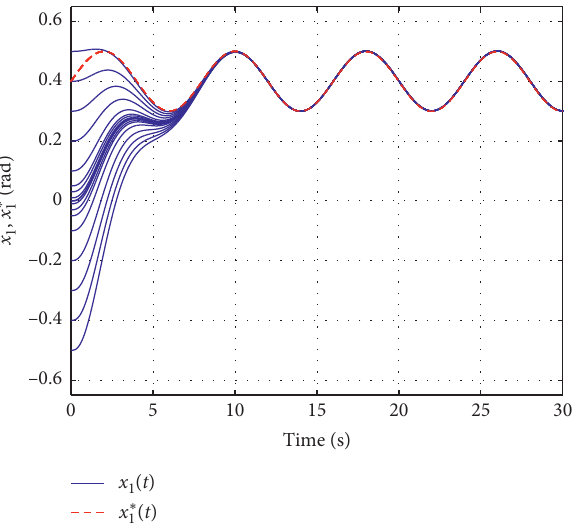
Figure 8: Output tracking response for a sinusoidal trajectory under different initial conditions.